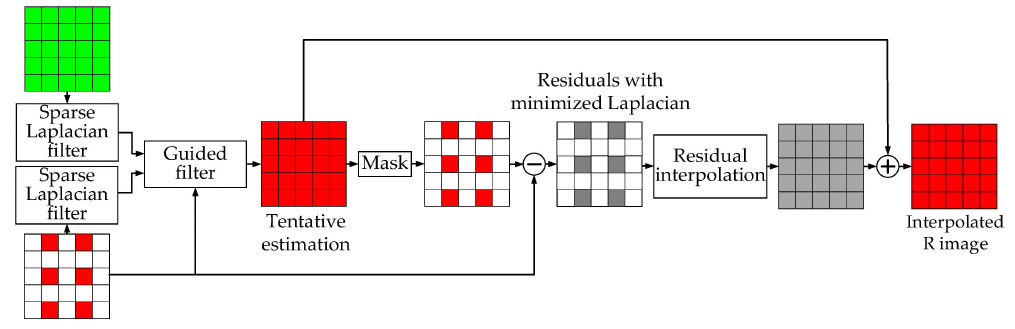
Figure 2. The interpolation of the R pixel values by using MLRI. Table 1. The sparse Laplacian filter used in